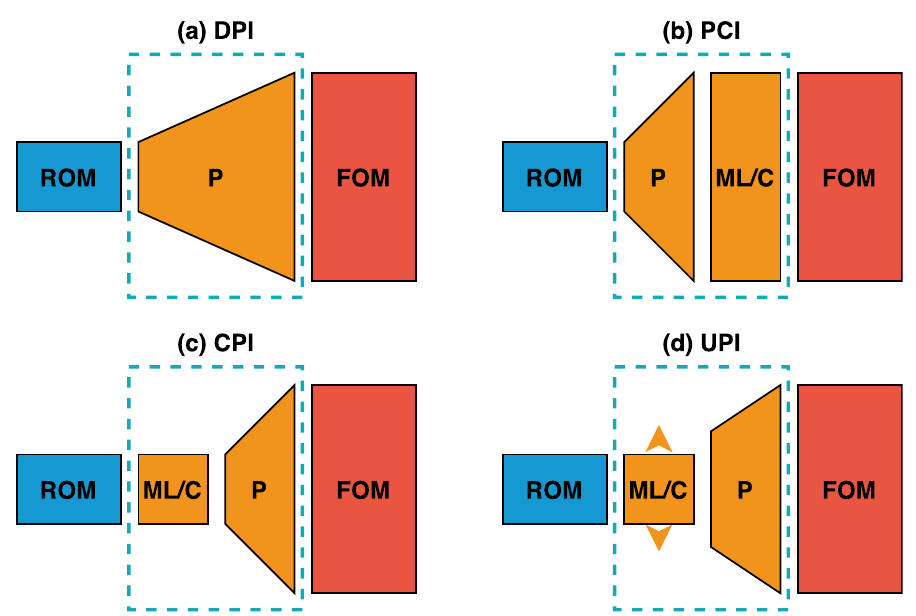
Fig 1. The proposed multifidelity concepts toward hybrid ROM/FOM coupling. Dashed blocks refer to the interface learning approaches introduced in the present work: (a) Direct Prolongation Interface (DPI), (b) Prolongation followed by a machine learning Correction Interface (PCI), (c) machine learning Correction followed by a Prolongation Interface (CPI), and (d) Uplifted Prolongation Interface (UPI) where the latent space is enhanced through machine learning before we apply the prolongation